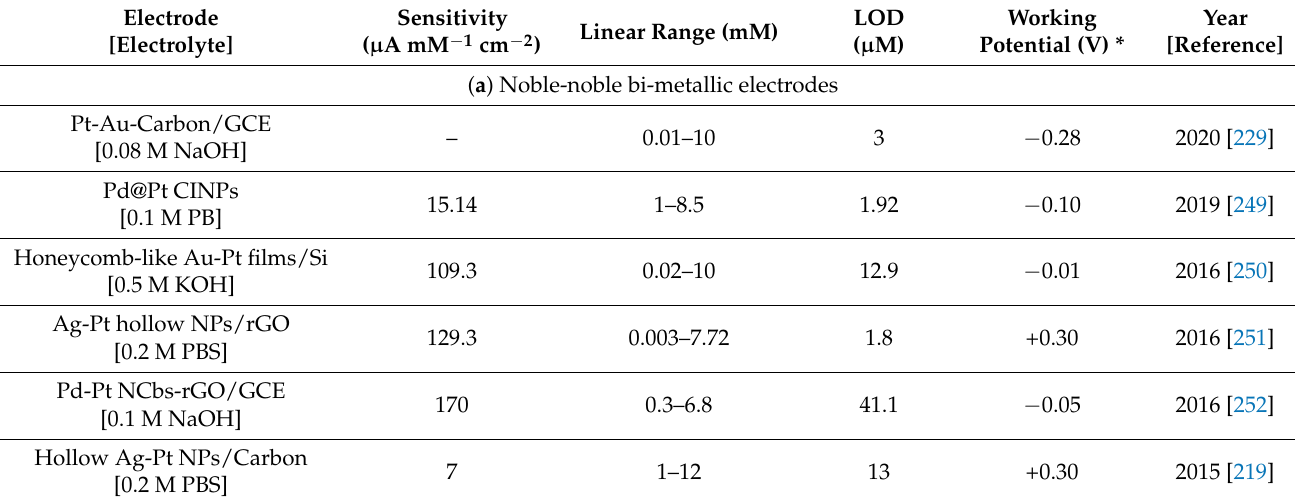
Table 4. The electrodes for the sensing of glucose by the ( a ) noble-noble, ( b ) noble-transition, and ( c ) transition-transition bi-metallic materials within this decade. The performances are compared in terms of sensitivity, linear range, limit of detection (LOD), and working potential. The working potentials are based on the reference electrode of Ag/AgCl.